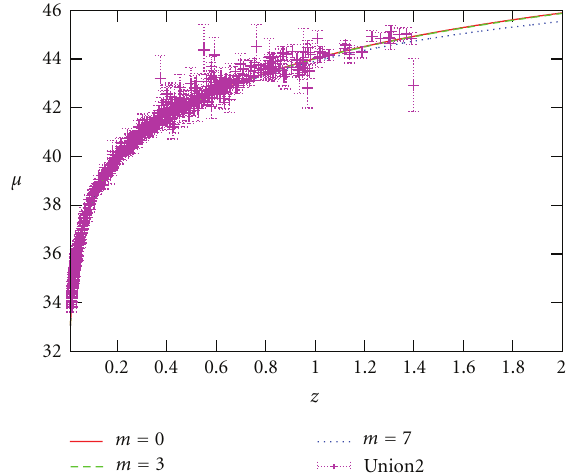
Figure 1: Illustration of the magnitude-redshift relation in S Λ CDM model ( m = 0) and D Λ CDM with Ω Λ 2 = 10 − 2 compared with SNIa observations (cross-shaped ones with error bars). Note that the theoretical curve for m = 3 has no di ff erence with that of m = 0. Figure 2: Constraints on the m